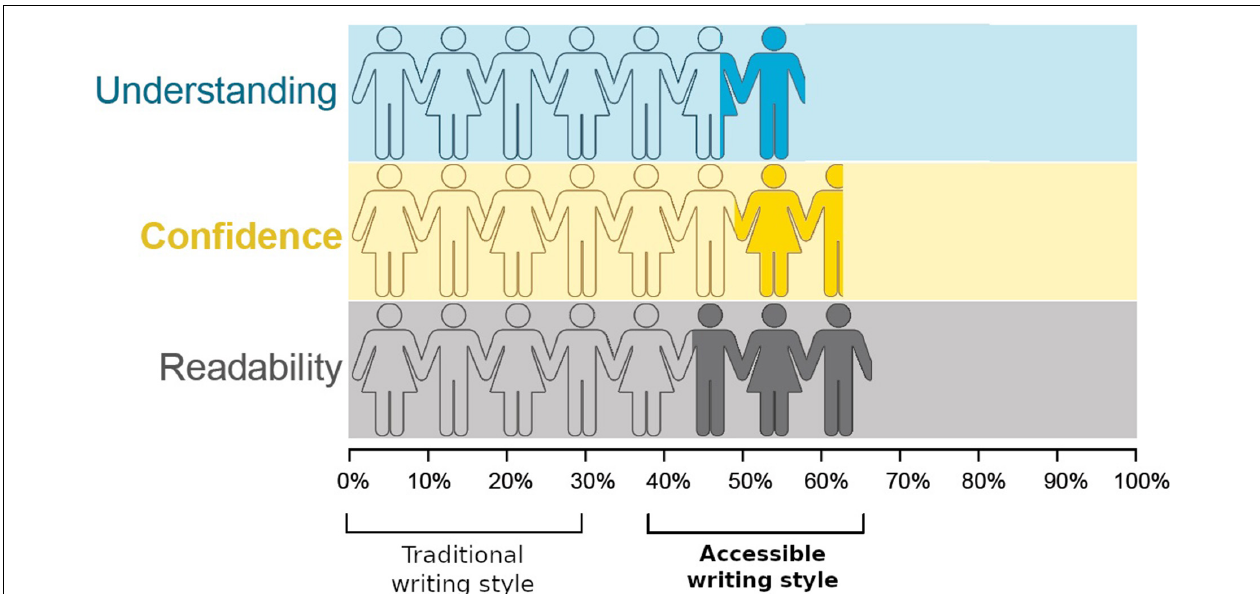
FIGURE 2 | Accessible writing boosts readability ( p < 0.001), reader understanding ( p = 0.027), and reader confidence ( p = 0.001). The stick figures represent the proportional gain in readability, confidence and understanding by writing in the most accessible style (filled figures), compared to the most traditional style of writing (hollow figures). Each stick figure represents